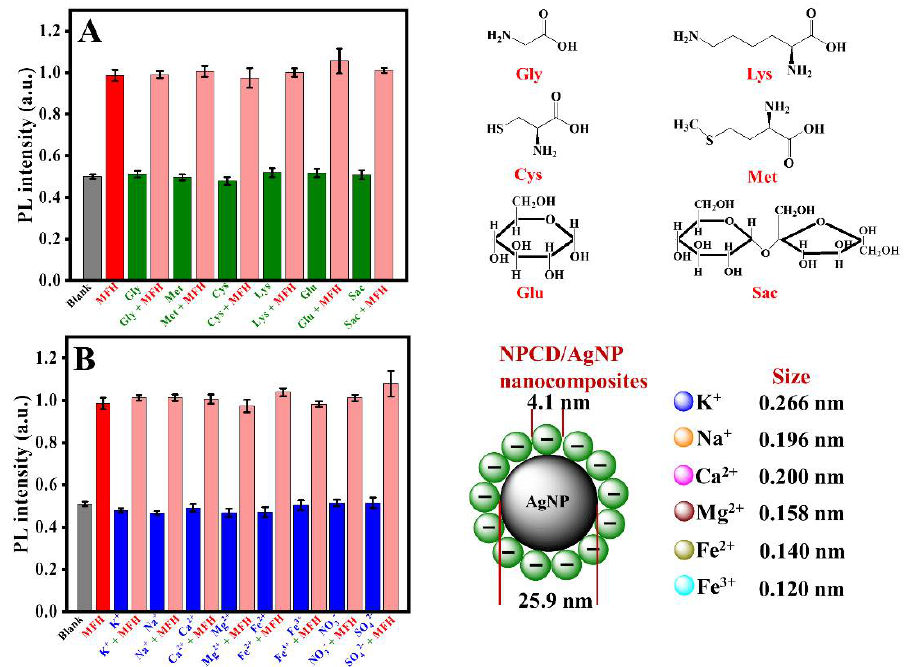
Figure 9. Fluorescence response of the NPCD/AgNP nanocomposites upon the addition of 50 µg/L of different substances ( A ), and ions ( B ).